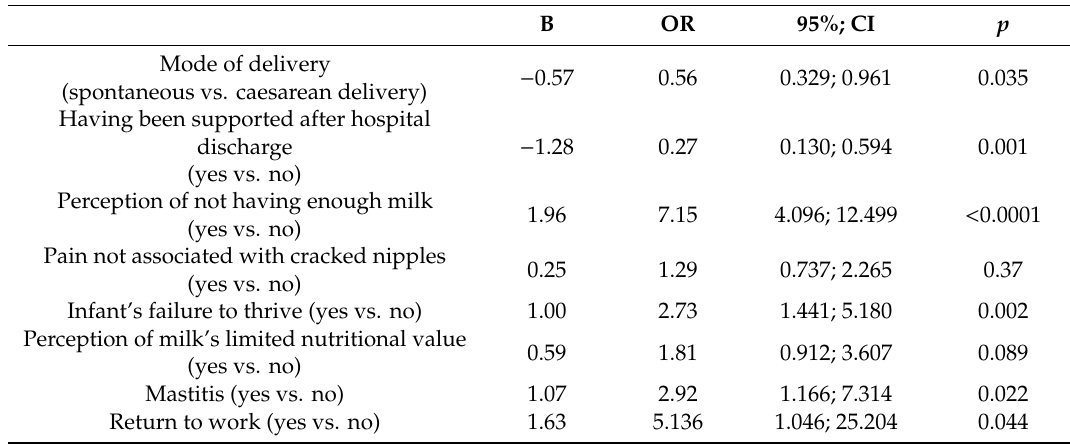
Table 5. Association among the mode of delivery, having been supported after discharge, the types of breastfeeding di ffi culties and the mode of infant’s feeding at three months (multivariate binary logistic regression